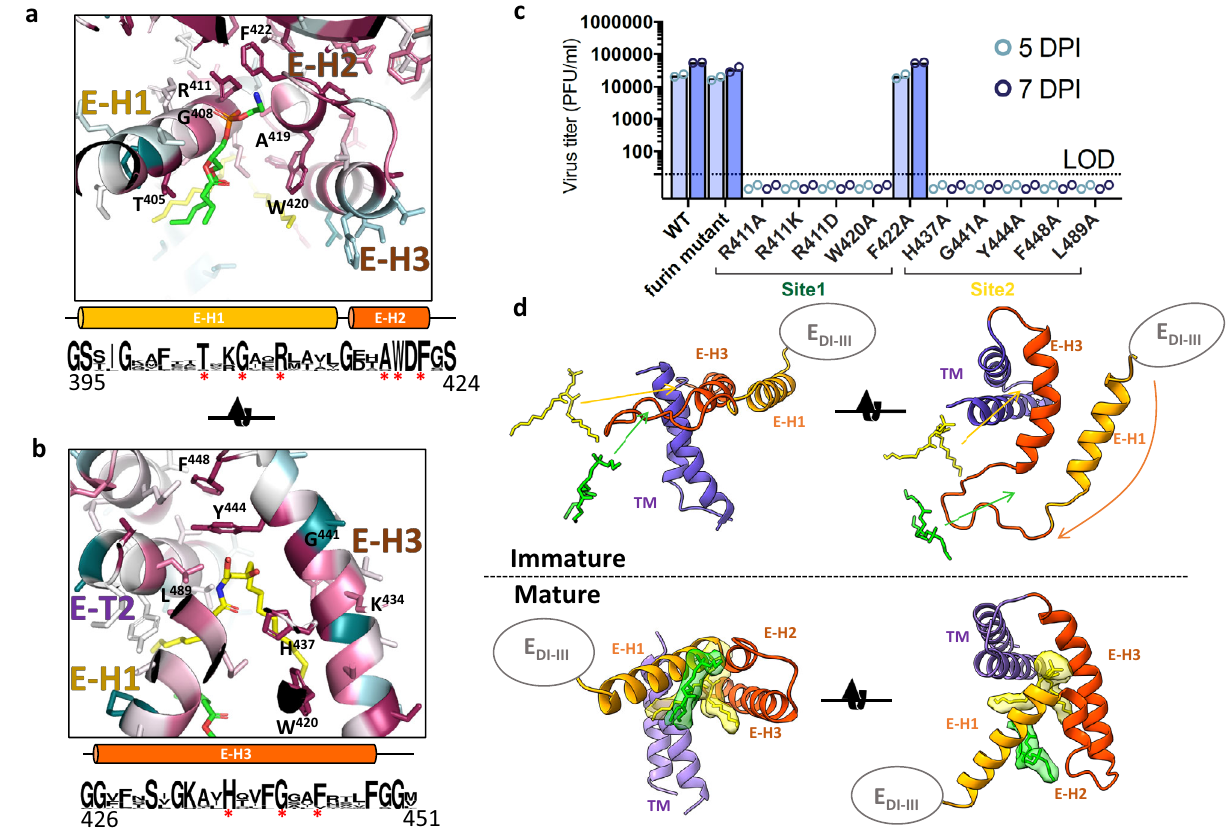
Fig. 9 A conserved binding site in fl aviviruses for lipid pocket factors. a , b Zooms of the lipid-binding sites in bDENV-2. The E protein (cartoon/sticks) is coloured by conservation from high (magenta) to low (cyan) based on an alignment of mammalian fl aviviruses (Supplementary Table 4). The sequence conservation is displayed as sequence logos where amino acids at each position are listed as stacked single letter codes in a font size proportional to the frequency of occurrence. The stem helices are shown as cylinders and contact residues between E and the lipids highlighted by red asterisks. c Replication of viruses containing site-speci fi c mutants was analysed at passage 1 by immunoplaque assay, recovery was only observed for mutant F422A. The open circles represent individual data point and bar graphs represent the mean value from two independent viral titrations. d Comparison of the TM, stem and ectodomain (E DI – III ) of E before/after maturation across the viral membrane (left) and from the outside of the particle (right). The membrane domain is display in a cartoon with H1 (yellow), H2 – H3 (orange) and the transmembrane helices (purple) labelled accordingly. For the mature structure, the lipid molecules are represented as sticks within a surface representation of the surrounding density from the reconstruction of mature bDENV-2. For the immature structure, the sequence of DENV-2 was mapped onto a previously deposited c-alpha model (PDB: 4B03) in Coot and used to generate a cartoon representation. Arrows indicate the positions of the pocket factors in the mature form. They do not represent the actual movement of lipids as their location in the immature state is